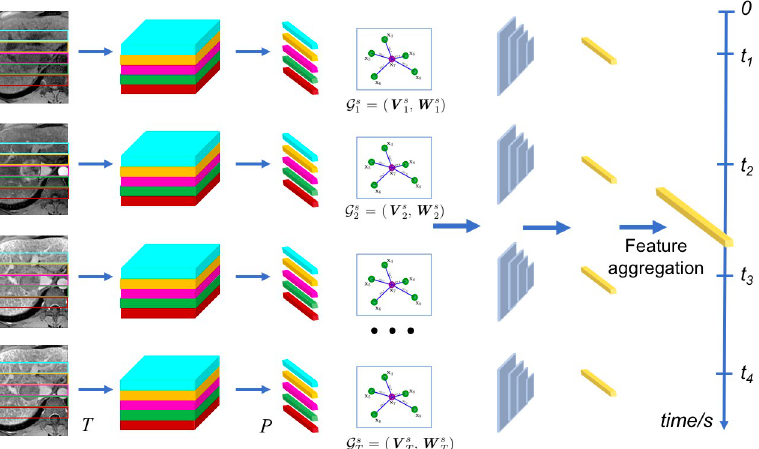
Fig 4. Schematic representation of the structural branch, where spatial relations between extracted patches from the single enhanced volumes are exploited in order to represent the morphological features from the DCE-MRI sequence. Graph nodes stemming from single volume feature patches are combined together in the discriminant graph network to form the feature vector of the structural data.